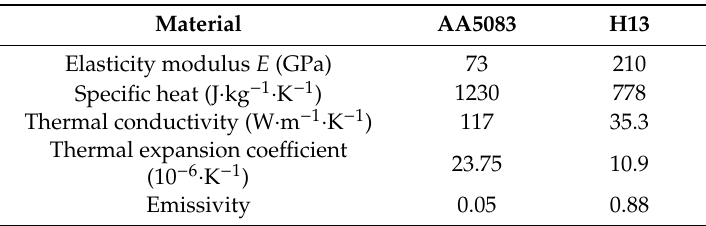
Table 2. Elastic and physical properties of materials.